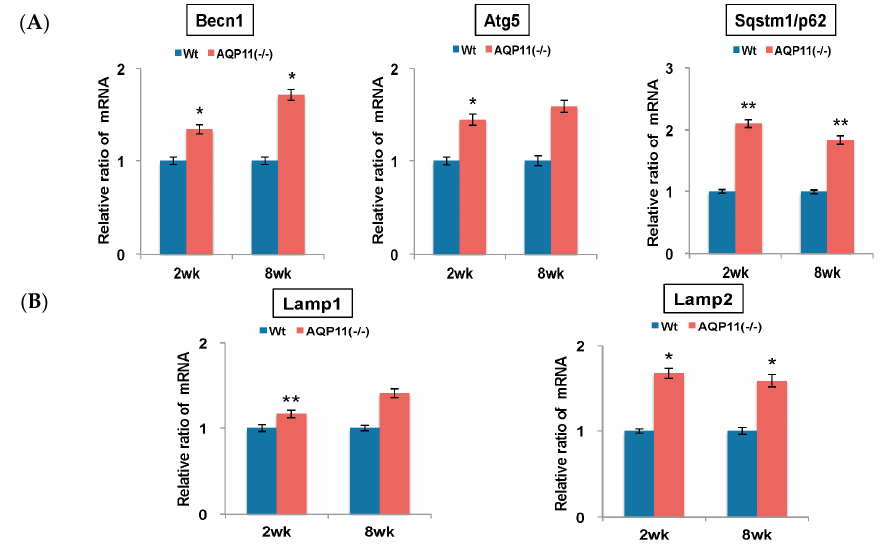
Figure 2. Quantitative analysis of autophagy-related genes in the kidney. All genes were compared by qRT-PCR between AQP11( − / − ) mice and wild-type mice (Wt) at two weeks (wk) old and at eight weeks old. The expression level in the age-matched wild-type kidney is arbitrarily normalized to 1. Individual genes were examined as follows: ( A ) Becn1, Atg5, and Sqstm1/p62 as markers for early autophagosome; ( B ) Lamp1 and Lamp2 as markers for late autophagosome. The results are shown by the mean +/ − SD. * p < 0.005 and ** p < 0.025 as compared with wild type ( n = 4 to 5 per group at two weeks old, n = 3 per group at eight weeks old.).